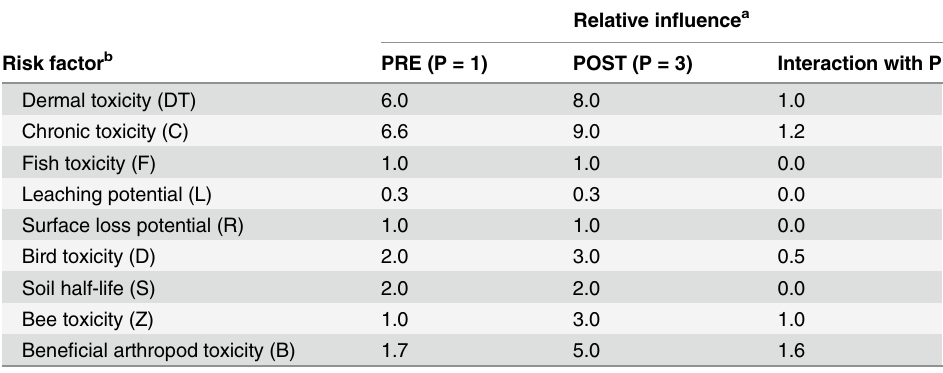
Because the P risk factor had such a strong relative influence on the resulting EIQ, the simu- lation results were disaggregated by P to determine the relative influence of the other risk fac- tors when herbicides were applied PRE (P = 1) compared to applied POST (P = 3), and a relative influence score was calculated for the interaction between each risk factor and P. This was of interest because P enters the EIQ formula multiple times in a multiplicative manner; that is, changing the value of P may increase or decrease the relative influence of other risk fac- tors. Plant surface half-life had no effect on the relative influence of fish toxicity, leaching potential, surface loss potential, and soil half-life (Table 2). Table 2. The influence of risk factors on the calculated environmental impact quotient (EIQ) as deter- mined by simulation analysis (N = 100,000) for herbicides applied before crop emergence (PRE) and herbicides applied after crop emergence